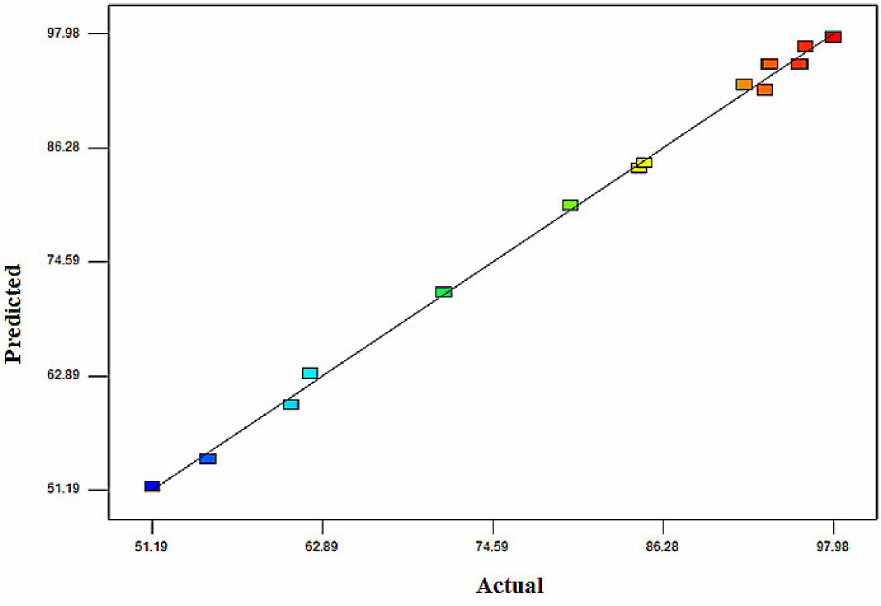
Figure 4. Correlation of predicted versus actual responses for the MB removal